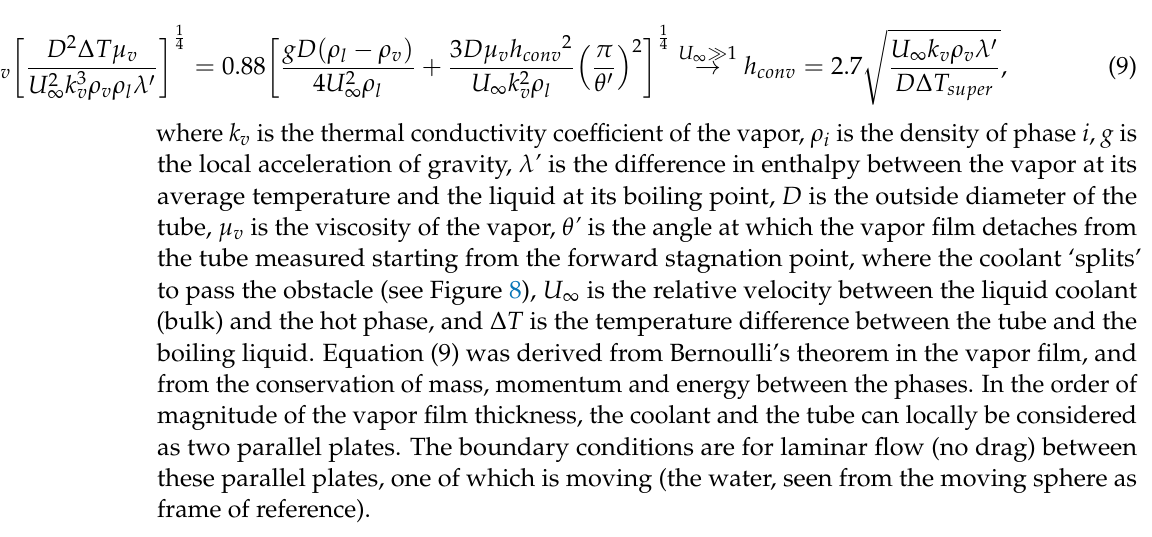
(11) with h tot the total heat transfer coefficient, h r the heat transfer coefficient for radiation, and h conv the heat transfer coefficient for convection. Here, h r is calculated with equation (11), where σ sb is the Stefan-Boltzmann constant, T i is the temperature of phase i (where ‘hot’ represents the hot sphere and ‘l’ the liquid coolant), and є i is the emissivity factor of phase i . Caution should be taken when using this equation as to what value is implemented for σ sb . Depending on the units, the factor 100 can be omitted [73,75,76]. In literature [67], one can find σ sb = 5.667 ∙ 10 − 8 W/m 2 K 4 , which is only valid without the factor 100. The factor 100 can be inserted in the equation (as in Equation (11)) if one uses σ sb = 5.667 W/m 2 K 4 . The factor 100 was left in Equation (11), but the correct value and units for σ sb (see Nomencla- ture) were used. The heat transfer coefficient for convection is less trivial to determine. Like Bromley et al. [73], Kobayashi [74] also had to calculate the results of his equation numerically. The obtained numerically-fitted equation is presented in Figure 9 for different Prandtl num- bers, where Nu , Pr , Re , R , ν l represent the Nusselt, Prandtl, and Reynold numbers, the radius of the sphere, and the kinematic viscosity of the liquid, respectively. From these figures, it is possible to determine the Nusselt number (and thus the heat transfer coeffi- cient) if one knows the other properties of the liquid, the vapor, and the flow.